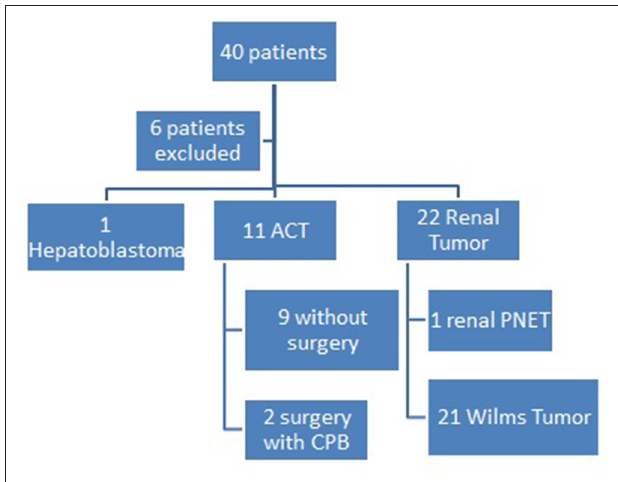
FIGURE 2 | Pediatric Oncology Institute - GRAACC casuistic on pediatric tumors with vascular extension.